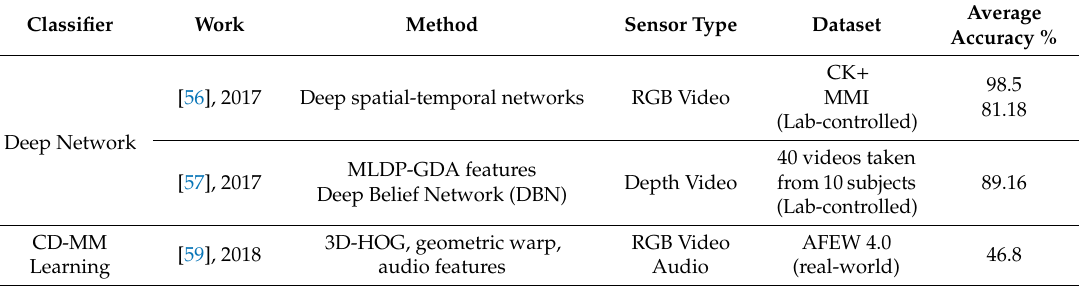
Table 2. Existing FER systems for resolving subject-dependence problem.